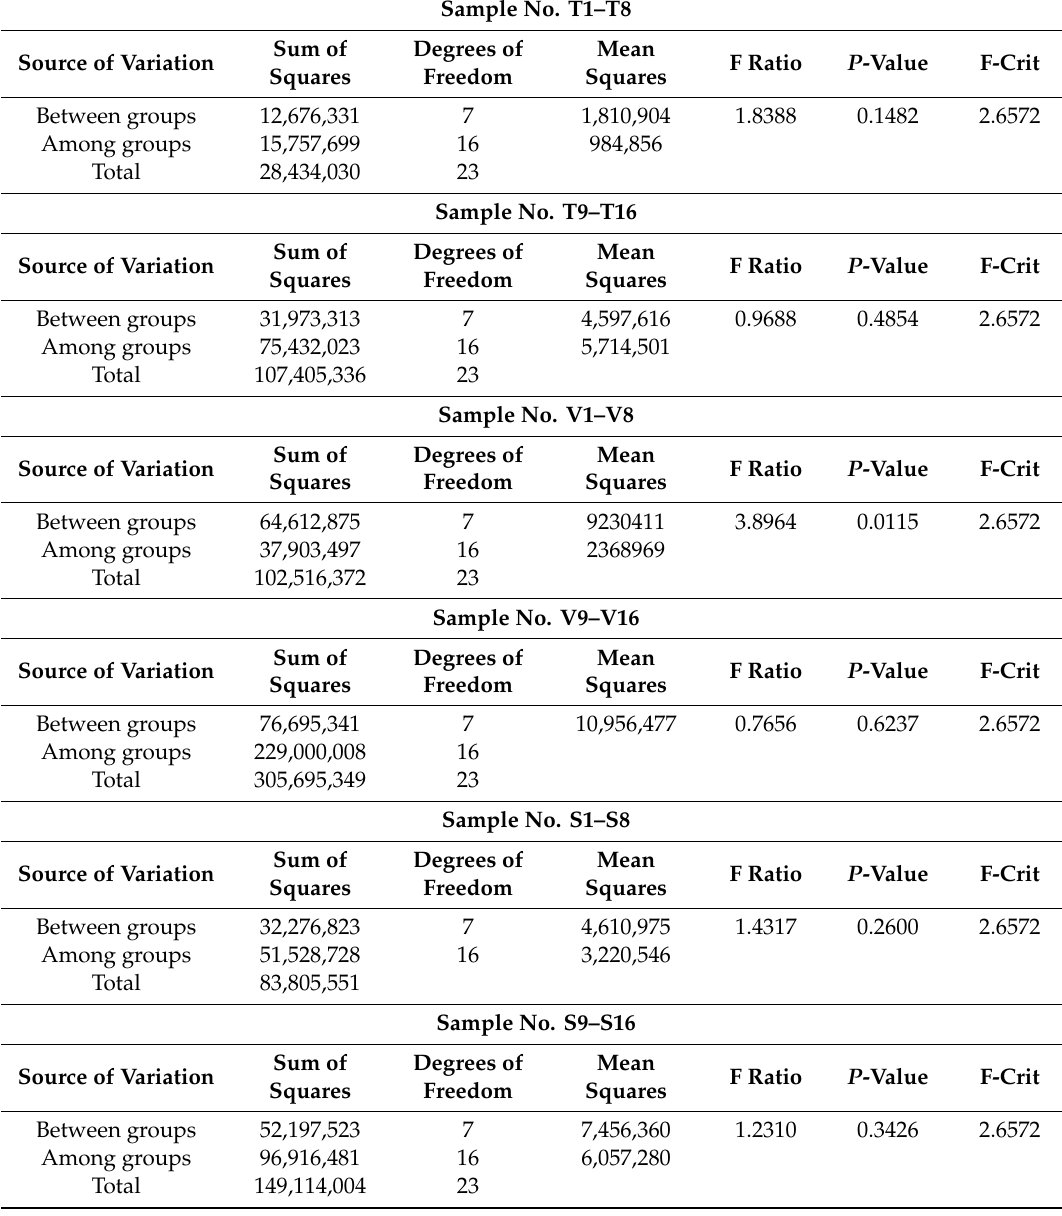
Table 4. Results of the evaluation of sample homogeneity. Sample No.